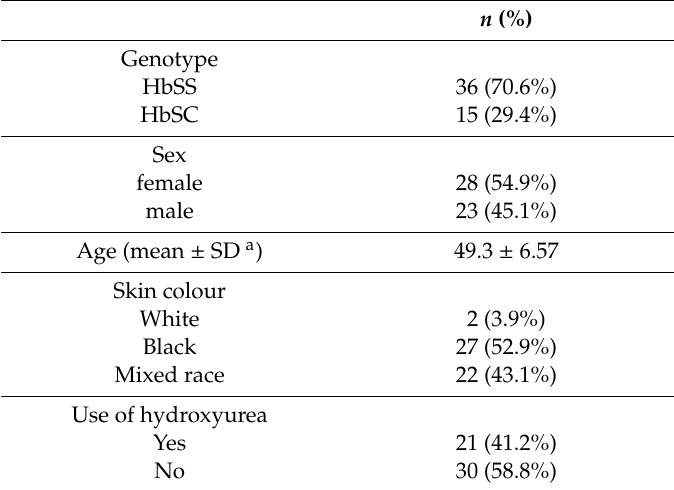
Table 1. Characteristics of adult sickle cell disease patients ( n =